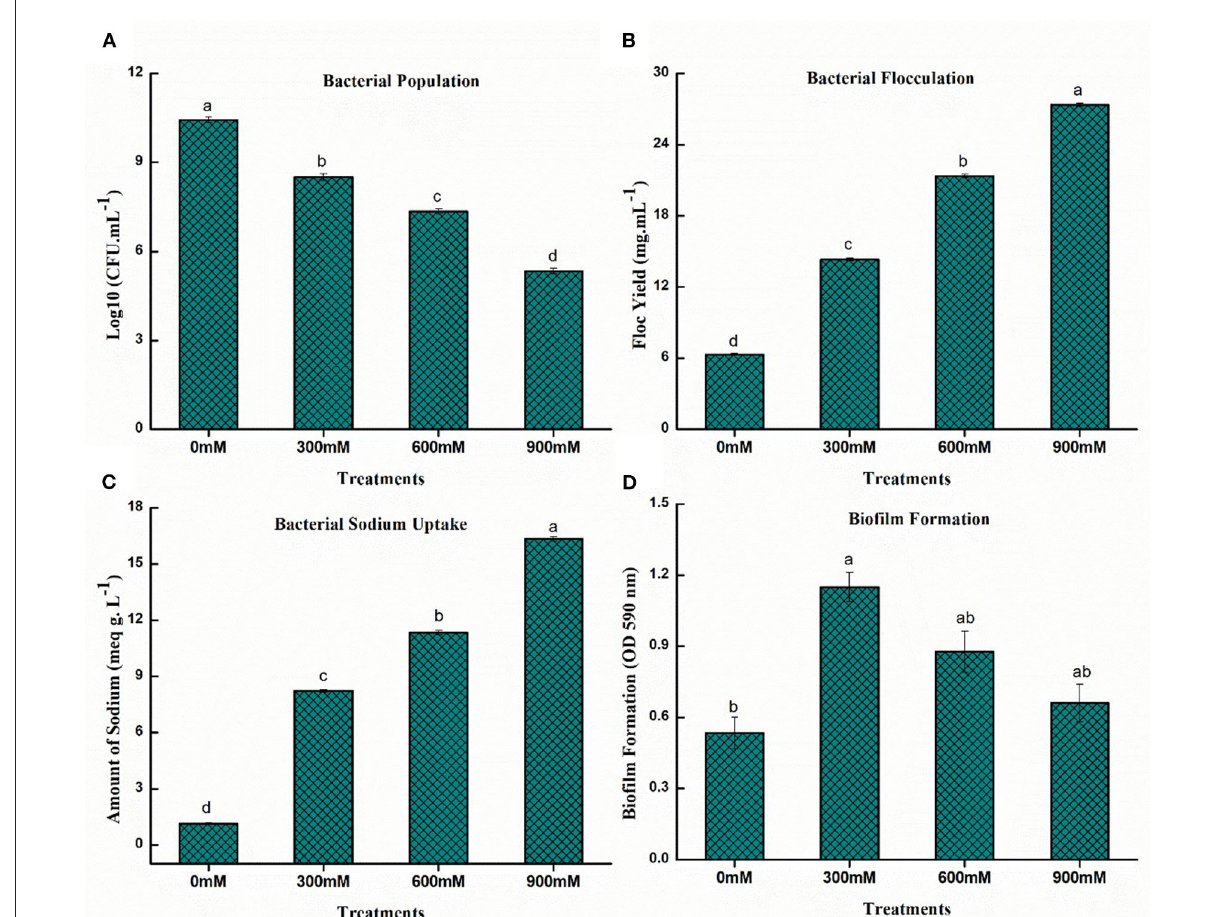
FIGURE2 Effects of NaCl on salinity tolerance traits of PM25 (A) Bacterial population (B) Flocculation yield (C) Bacterial Na + uptake (D) Biofilm formation. Bars sharing different letter (s) for each parameter are significantly different from each other according to the Least Significant Difference (LSD) test ( p ≤ 0.05). All the data represented are the average of three replications ( n = 3). Error bars represent the standard errors (SE) of three